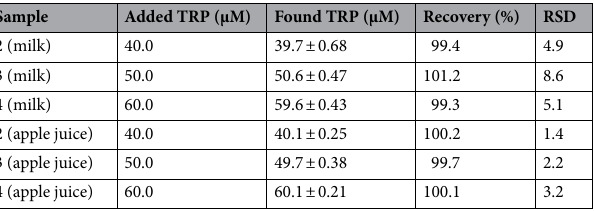
Table 1. Determination of L-tryptophan in milk and apple juice samples in Britton–Robinson buffer solution at graphite electrode (N = 3).